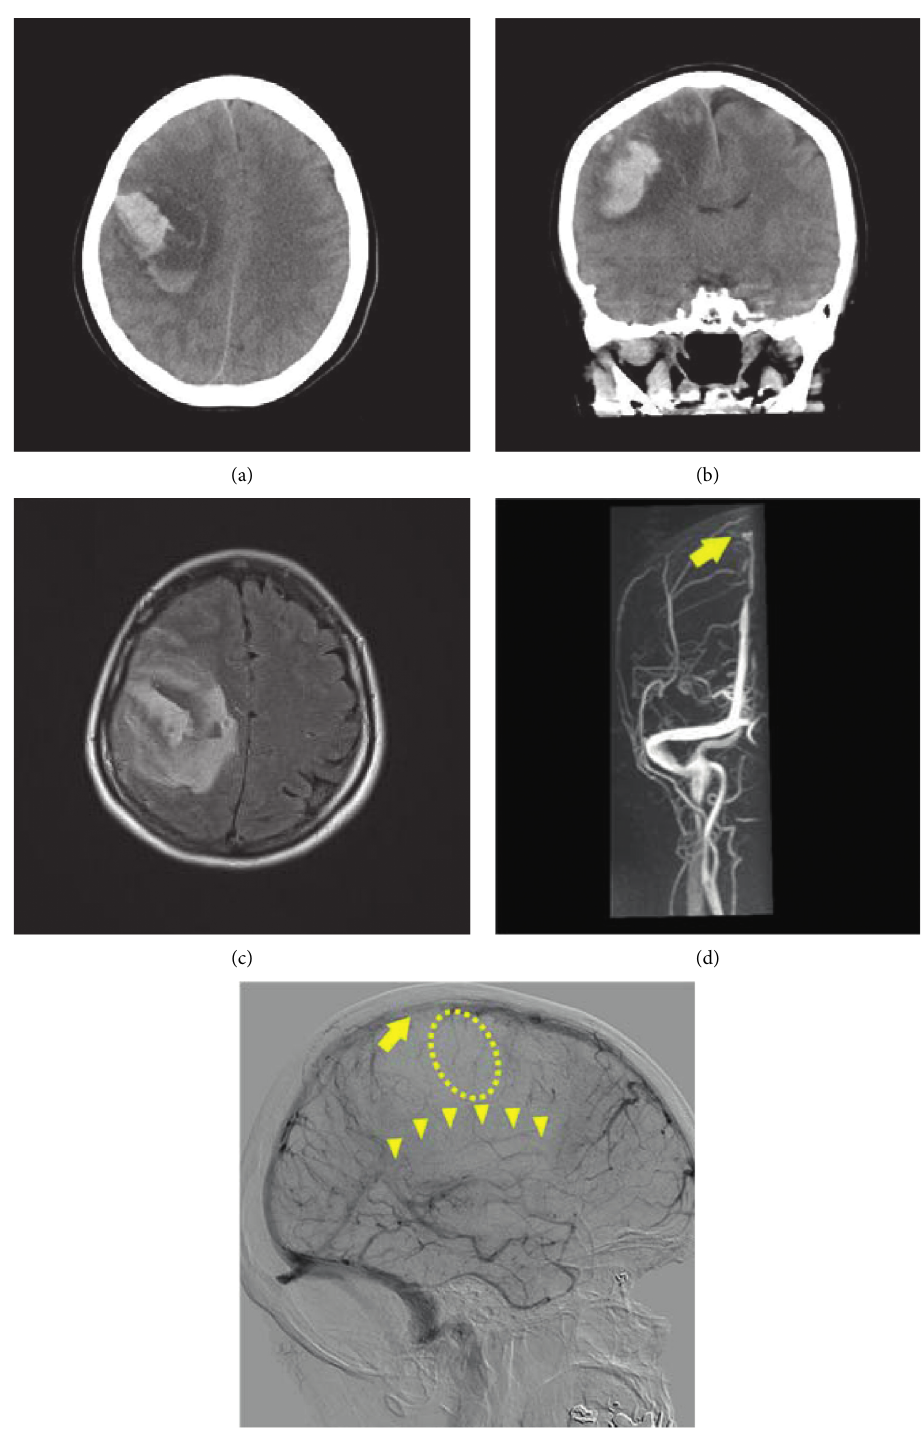
Figure 1: (a) Sagittal and (b) coronal images of nonenhanced brain computed tomography (CT) showing a high-density area in the right frontoparietal lobe, consistent with right lobar intracranial hemorrhage (ICH). (c) A head magnetic resonance image (MRI) with fluid attenuation inversion recovery (FLAIR) showing infarction surrounding subcortical hemorrhage of the frontoparietal lobe. (d) Magnetic resonance venography (MRV) revealing an absence of normal flow patterns of the superior sagittal sinus (arrow). (e) Cerebral angiogram showing total occlusion of the right rolandic vein (dotted circle) and inferior sagittal sinus (arrow heads) and partial occlusion of the superior sagittal sinus (arrow) caused by thrombosis (Figure